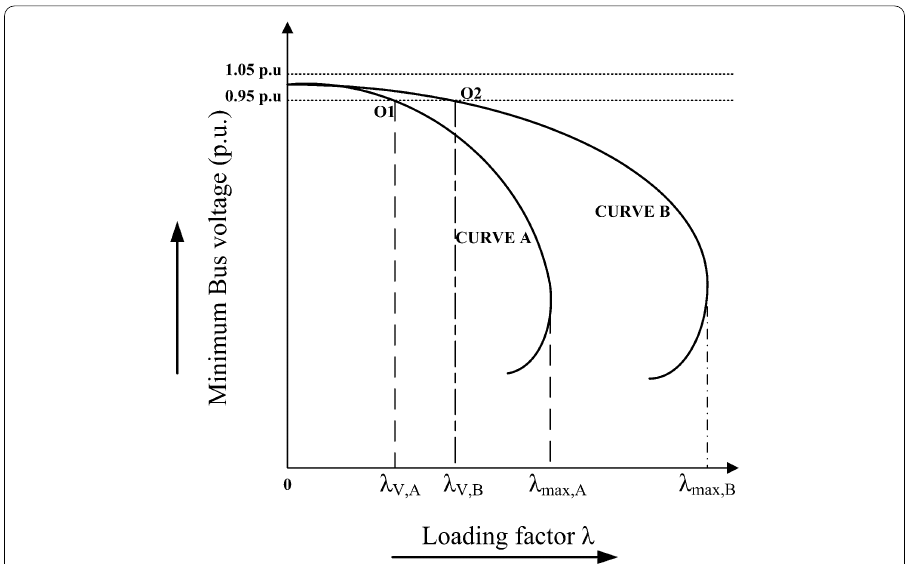
Fig. 1 Impact of DGs placement and Network reconfiguration on system